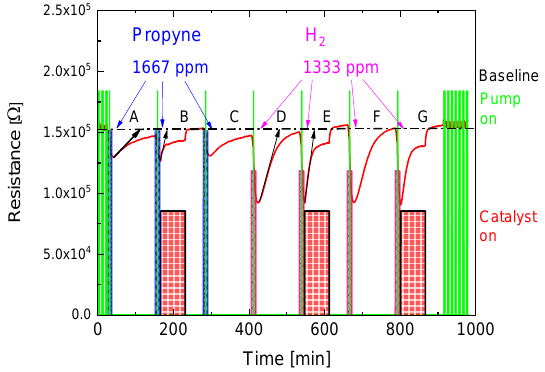
Figure 8. Variation of MOX sensor resistance in response to three propyne (A, B, C) and four H 2 sampling processes (D, E, F, G). Catalyst activation (thick red bars) clearly enhances the speed of return to the sensor baseline resistance after reactive gas sampling. Return rates (black arrows) are seen to be gas-species dependent thus providing an additional measure of the reactivity of the sampled gas.